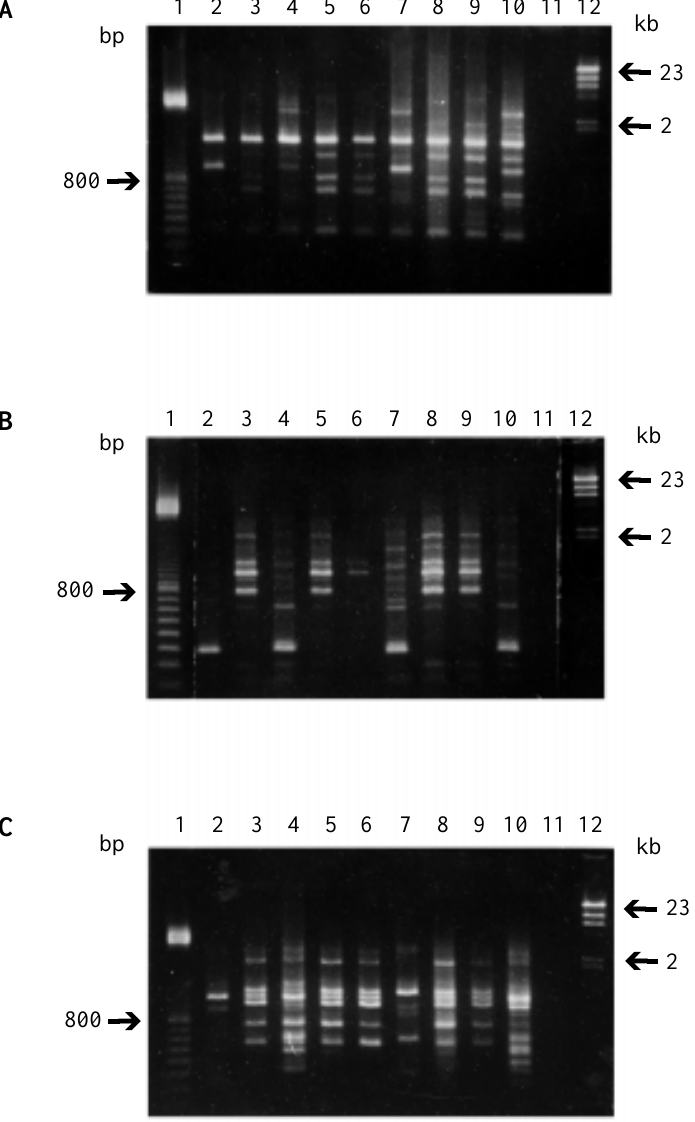
Figure 1A to 1C - RAPD-PCR profiles of amplification from DNA of serotype O:3 Yersinia enterocolitica pig strains. Lanes 2: Ye 41; 3: Ye 2; 5: Ye 1; 8: Ye 5, and 9: Ye 5A. Idem with serotypes O:13, O:6, O:5 and O:4 Y. enterocolitica human strains. Lanes 4: Ye184p; 6: Ye 43p; 7: Ye 102p, and 10: Ye 124p. Lanes 1: 100-bp DNA ladder; 11: negative control, and 12: l Hin dIII. 1A. Amplification with primer 786, 1B. amplification with primer 795 and 1C. amplification with primer